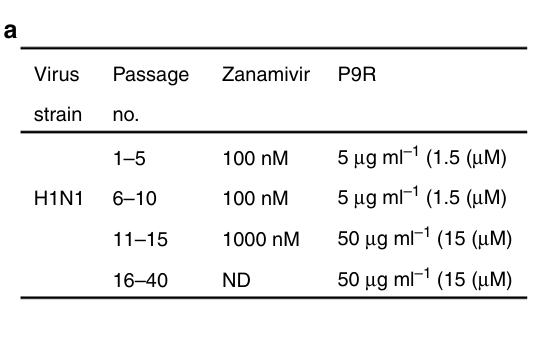
all peptides was >95%. The purity and mass of each peptide were veri fi ed by HPLC and mass spectrometry. Plaque reduction assay . Antiviral activity of peptides was measured using a plaque reduction assay 14 . Brie fl y, peptides were dissolved in 30 mM phosphate